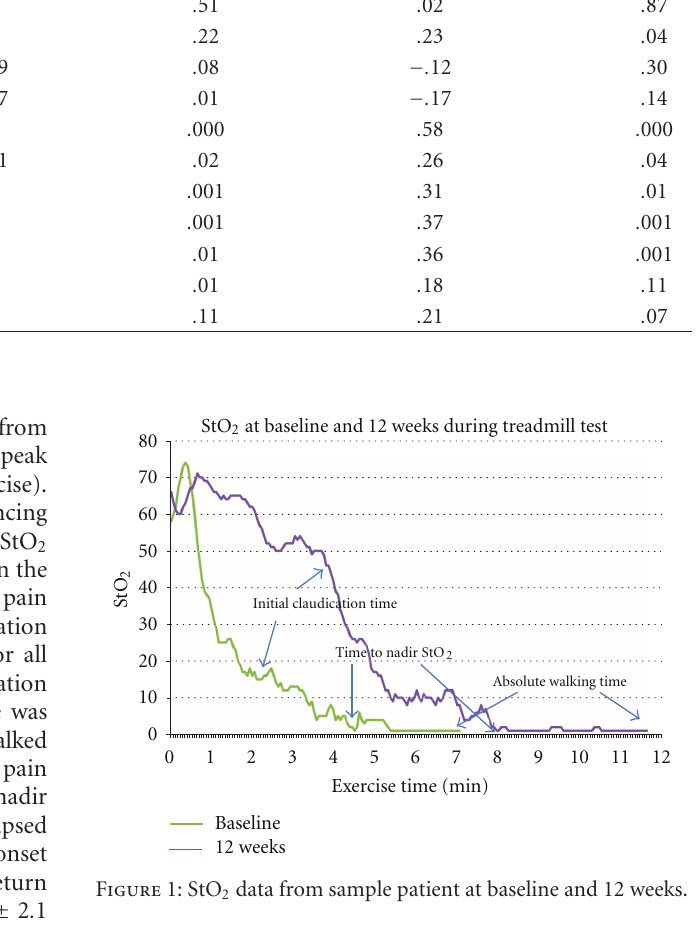
traditional walking group when compared to the walking- with-poles group. There was, however, no di ff erence in the change in initial claudication time between the two groups ( P = . 38). When the analyses were restricted to those who com- pleted the exercise training only ( n = 71), the change in time elapsed prior to reaching nadir StO 2 values between baseline and 12 weeks was related to the change in absolute walking time between baseline and 12 weeks ( r = .57, P < . Figure 1. Recovery time was unchanged when baseline and 12-week values were compared (baseline = 2 . 45 ± 2 . 17 min, 12 wk = 2 . 19 ± 1 . 94 min, P = . 81). After 12 weeks of exercise training, within-group changes in initial claudication time, absolute claudication time and time elapsed prior to reaching nadir StO 2 values increased (Table 4.) The time elapsed prior to reaching nadir StO 2 values increased more in the traditional walking group when compared to the walking- with-poles group (walking group = 4 . 01 ± 5 . 13 minutes, walking-with-poles group = . 89 ± 3 . 56 minutes, P = .